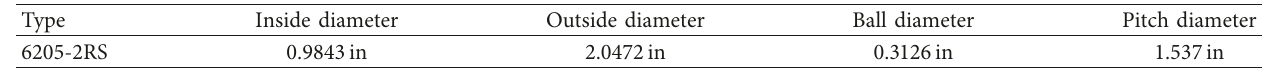
Figure 22: (a) Time-domain waveform diagram of the signal component with the maximum kurtosis found by the new method and its frequency band and (b) its envelope sequence. Table 8: Parameters of the bearing.